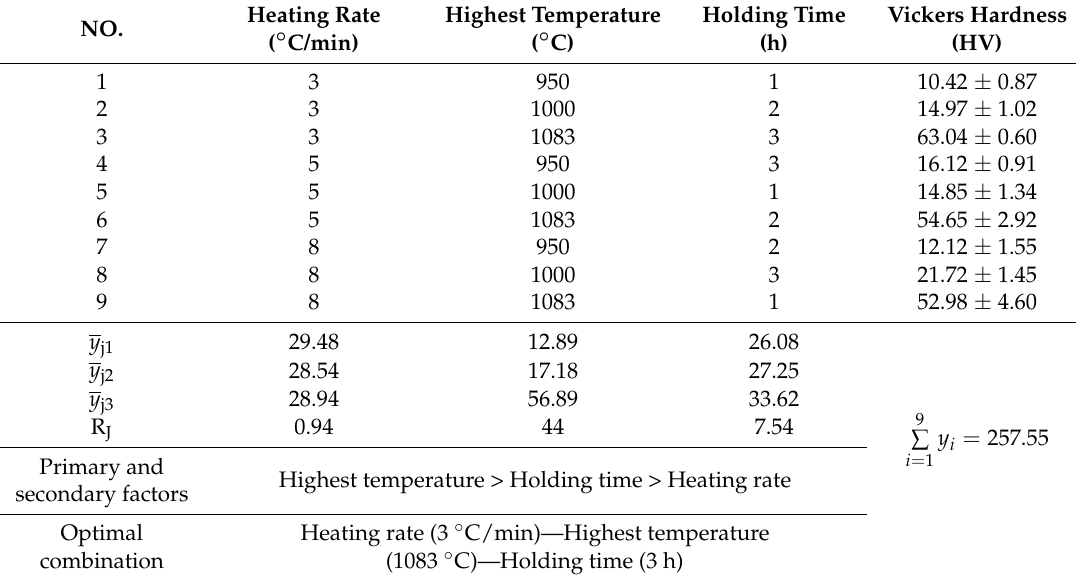
Table 7. Orthogonal table of the sintering parameters and hardness of the sintered